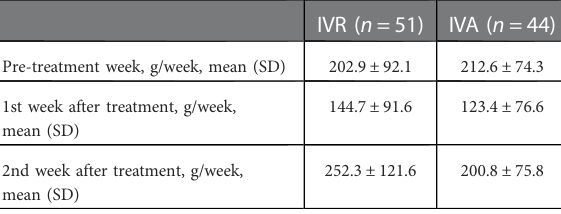
TABLE 2 Comparison of weekly BW gain before and after treatment in the two